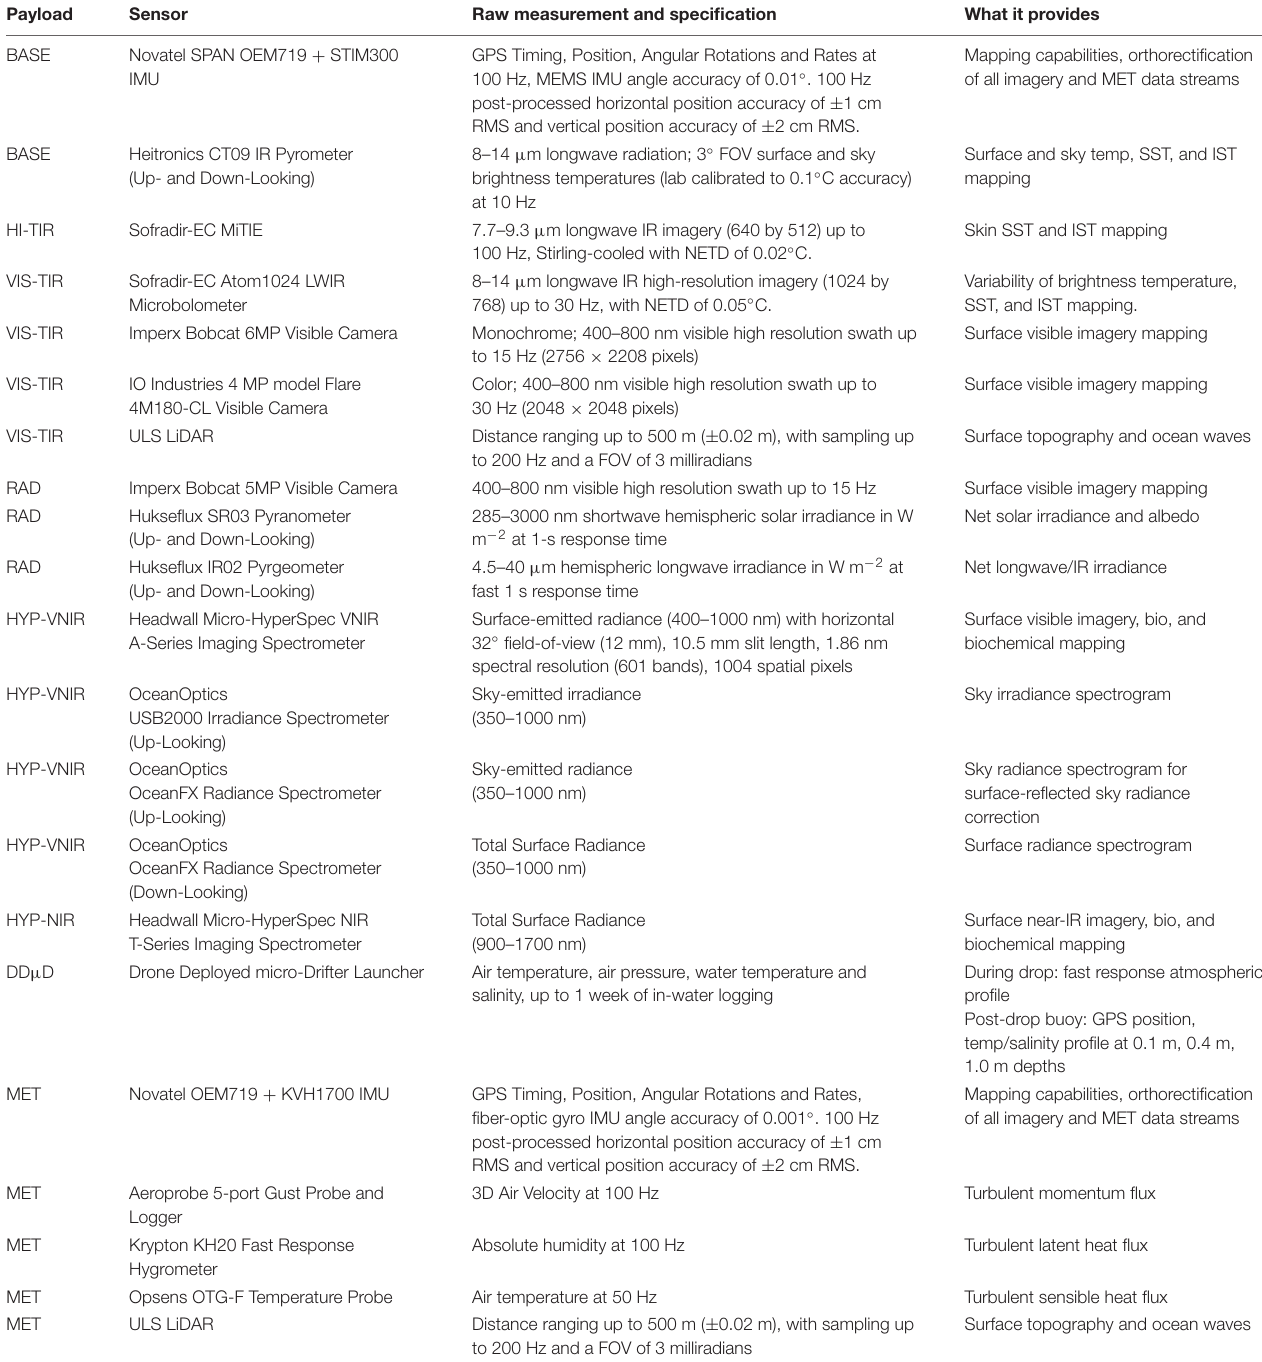
TABLE 1 | Description of each instrument payload, including sensor components, measurement outputs and performance specifications. Payload Raw measurement and